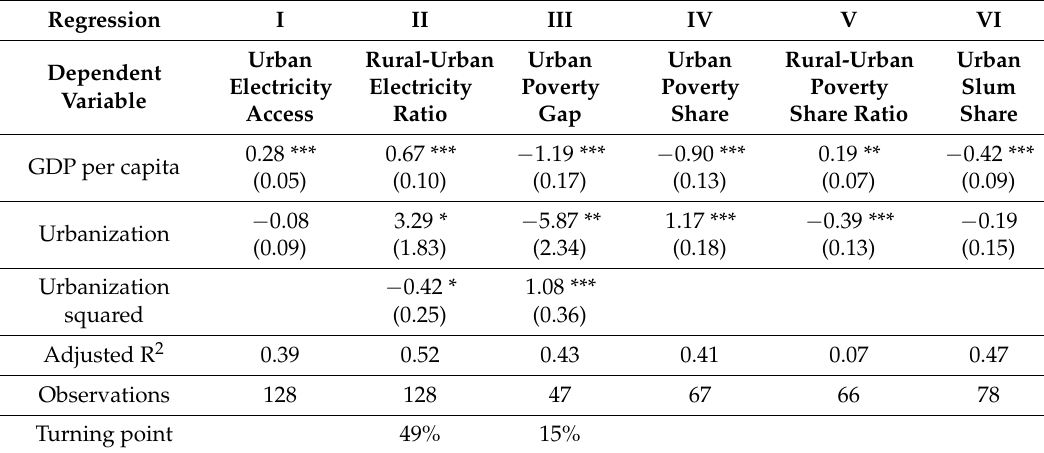
Table 3. Cross-sectional regressions of the effects of GDP per capita and urbanization on urban poverty indicators and rural-urban poverty